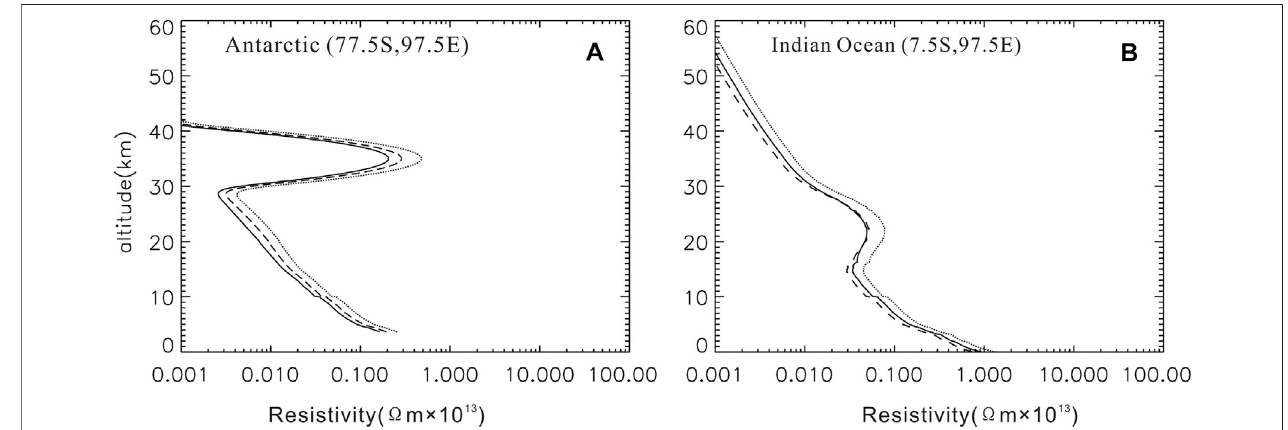
FIGURE 7 | Vertical pro fi le of atmospheric resistivity in DJF in the (A) Antarctic and (B) Indian Ocean. The solid lines are for 1990 – 1991, dotted lines are for 1992 – 1993, and dashed lines are for 1993 – 1994.